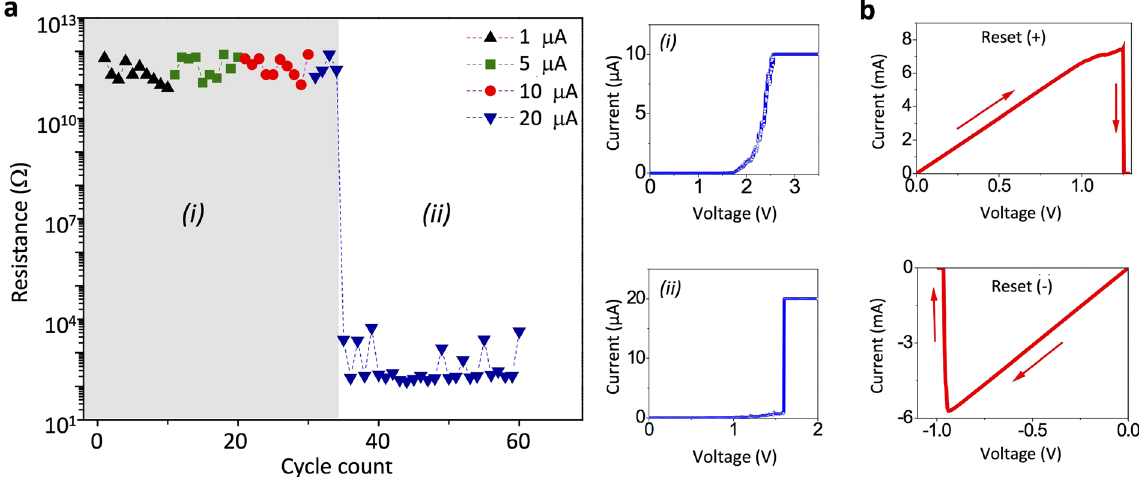
Figure 3. ( a ) Resistances of an as-prepared Pt/TiO 2 /Pt cell measured after a set process with compliance currents of 1, 5, 10 and 20 μ A. Each cell resistance measurement was performed after a set process on a new location of the Pt substrate. The upper and lower graphs on the right side show typical I-V behaviors before and after the transition into a unipolar switching, respectively. ( b ) A unipolar reset processes with positive (left) and negative (right) bias to the Pt